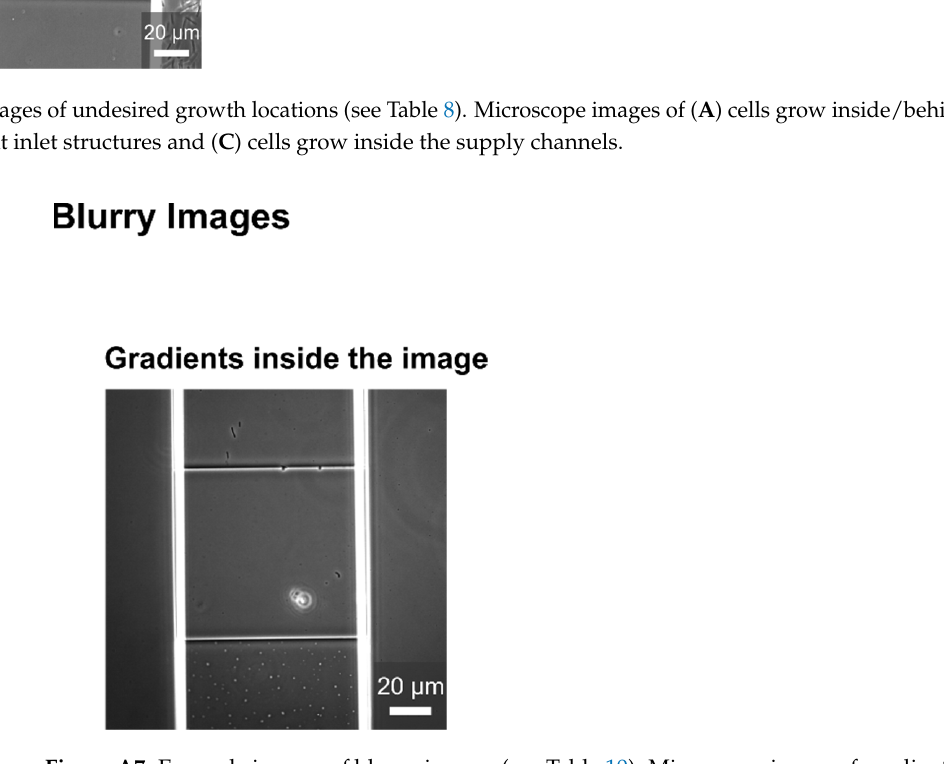
Figure A7. Example images of blurry images (see Table 10). Microscope image of gradients inside the image.